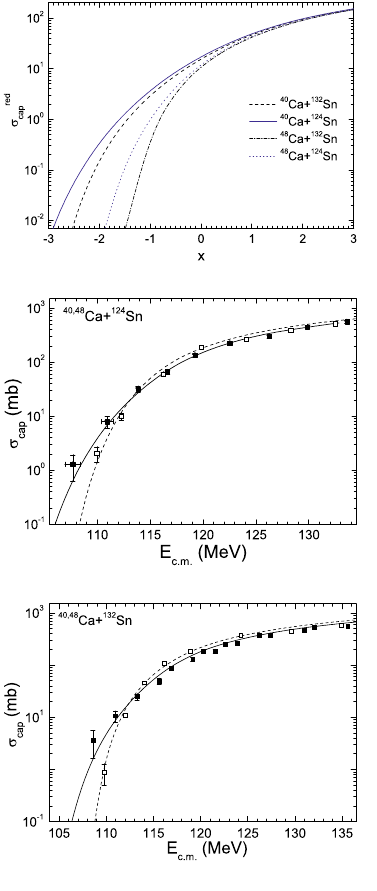
Figure 3. (Color online) The calculated reduced capture cross sections versus ( E c . m . − V b ) / ( (cid:2) ω b ) in the reactions 40 Ca + 124 Sn (solid line), 48 Ca + 124 Sn (dashed line), 48 Ca + 124 Sn (dotted line), and 48 Ca + 132 Sn (dash-dotted line).